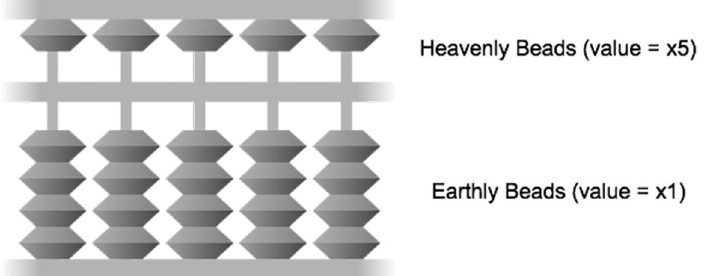
Figure 1. A typical abacus consists of several vertical columns upon which beads move freely. A horizontal beam divides each column into an upper and a lower deck. Each column has 4 or 5 beads on the lower deck (“earthly beads”) and 1 or 2 beads on the upper deck (“heavenly beads”). On a column chosen by the user, each bead in the lower deck represents a cardinality of one, and each bead in the upper deck represents five. Lower deck beads on the next column to the left represent multiples of 10 (and 50 on top), and beads on the next column represent multiples of 100 (and 500 on top), etc. Beads are “in play” (contributing to a numerical representation) when moved towards the central